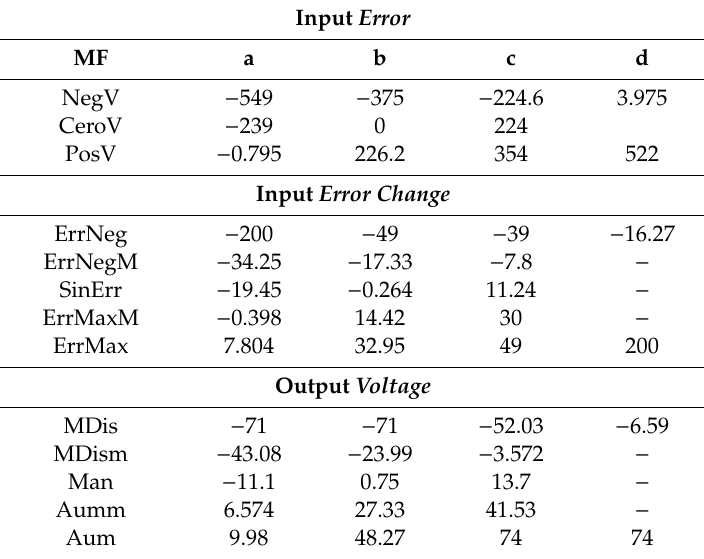
Table 7. FLC membership functions for signal generator reference.